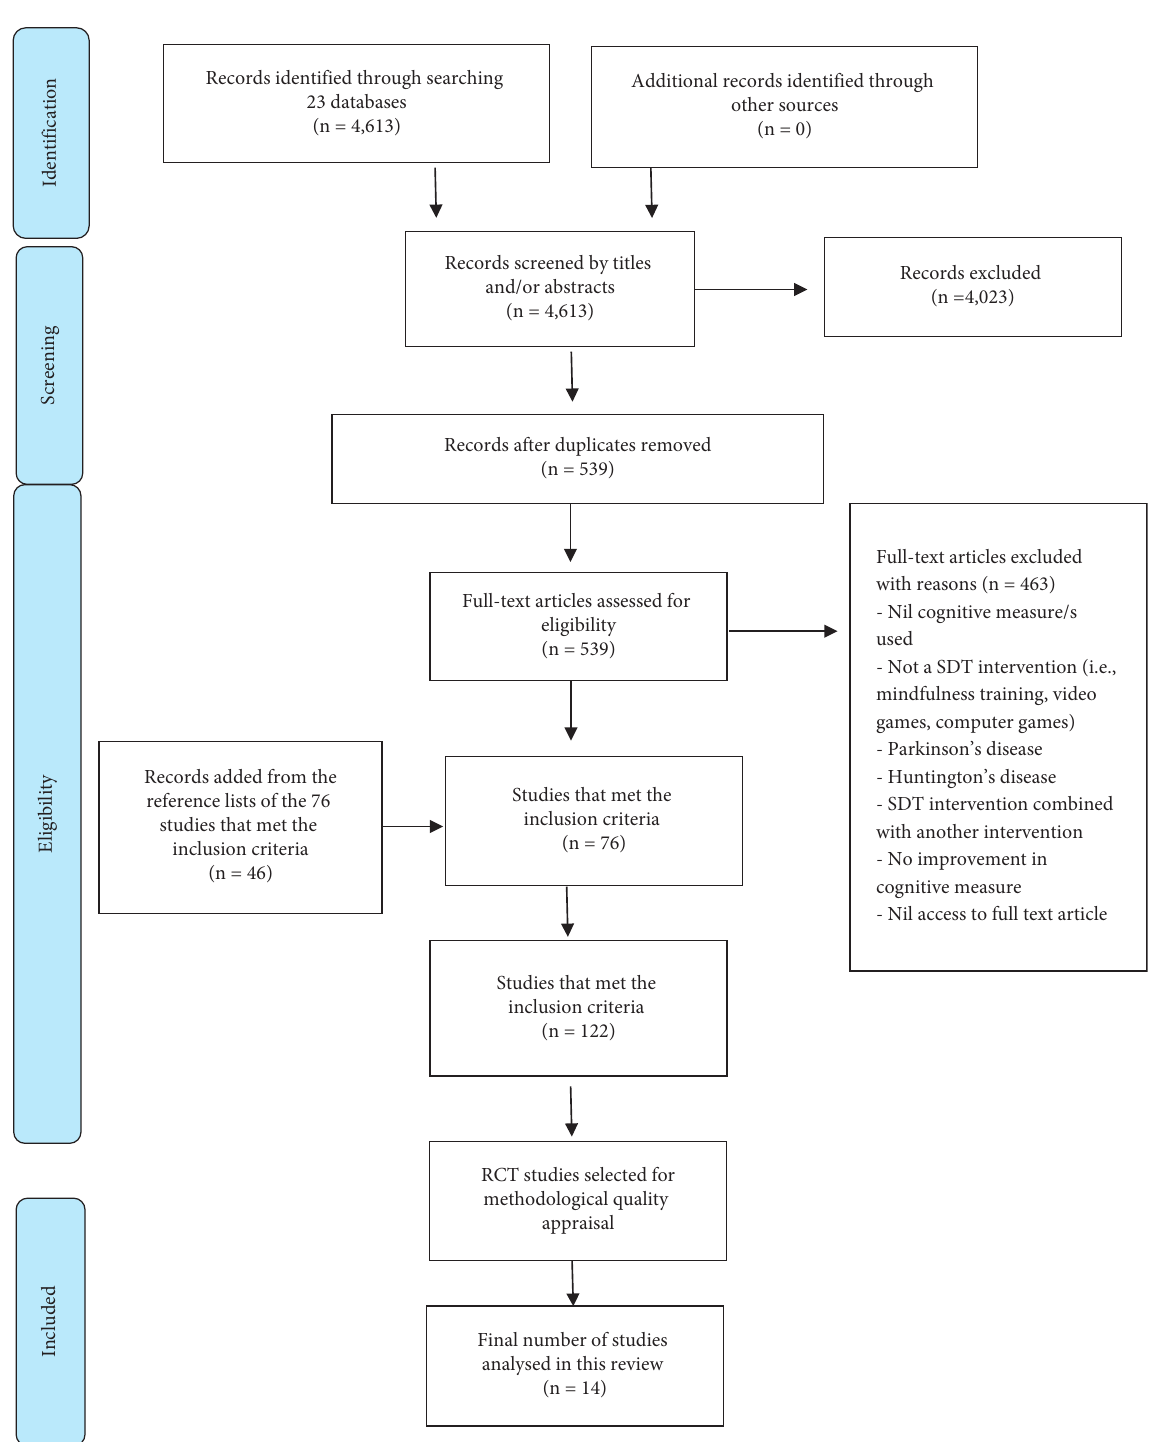
Figure 1: PRISMA